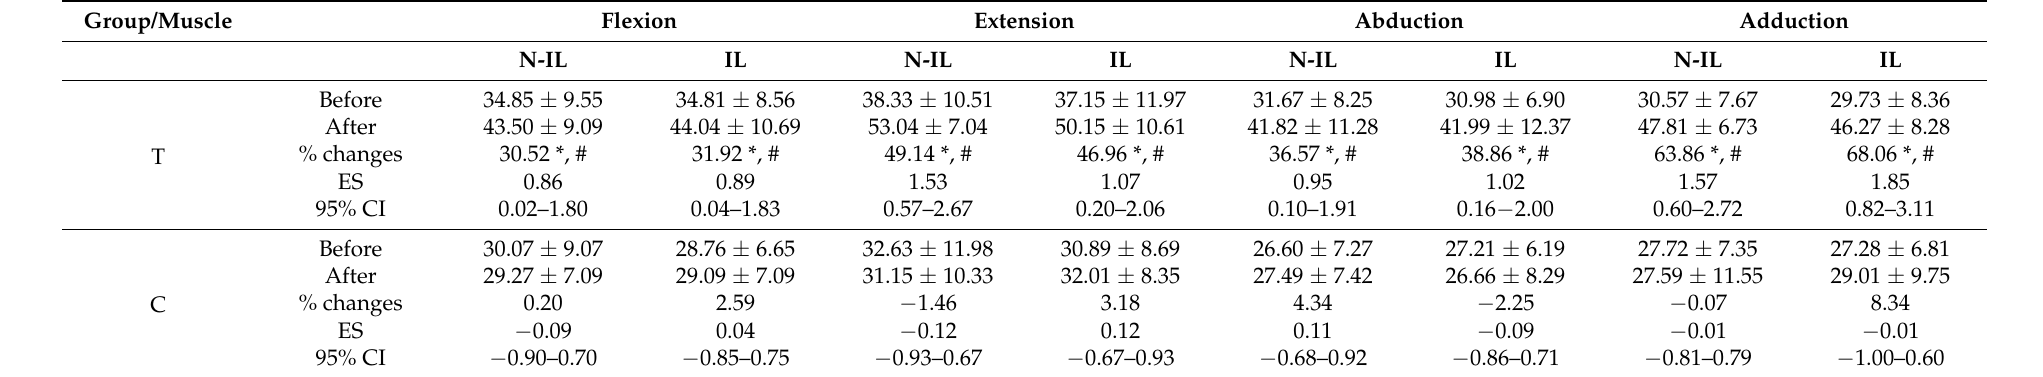
Table 2. Absolute values of strength (N), strength changes (%), and ES in tested shoulder muscles. Group/Muscle Flexion